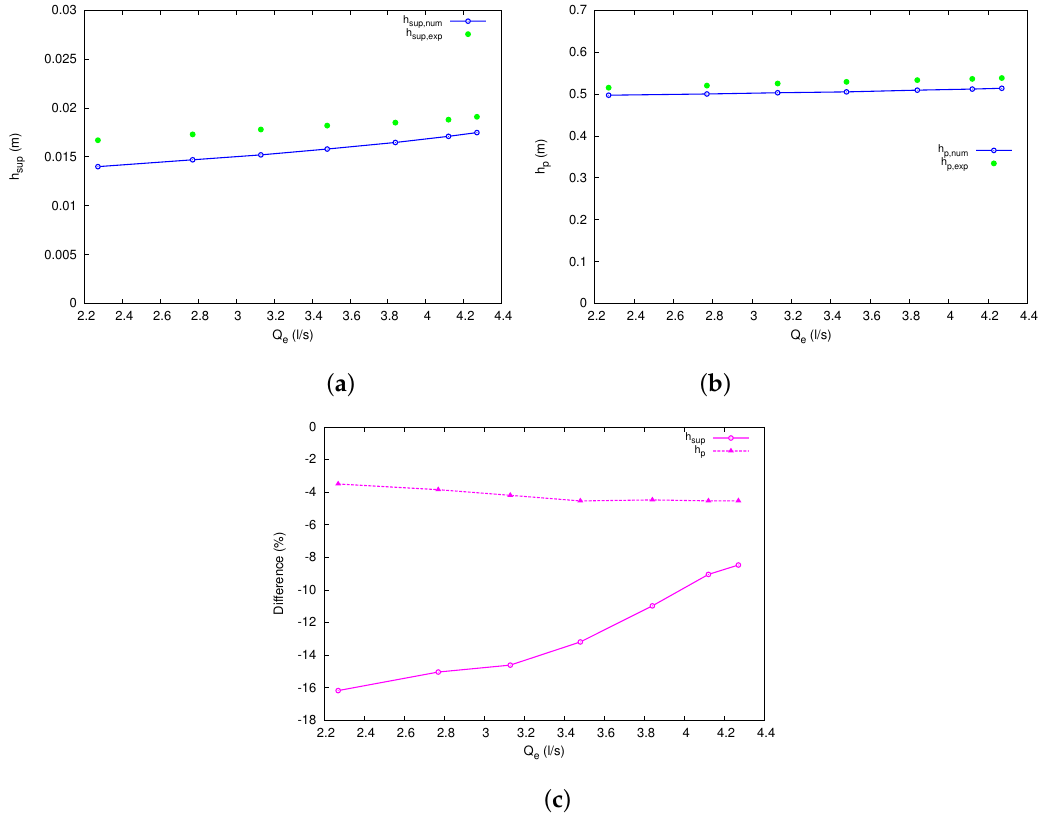
Figure 8. Case 1.2. Comparison between numerical and experimental data for the surface water depth ( a ) and pressure head ( b ). Relative differences (%) between numerical and experimental data for the surface water depth and pressure head ( c